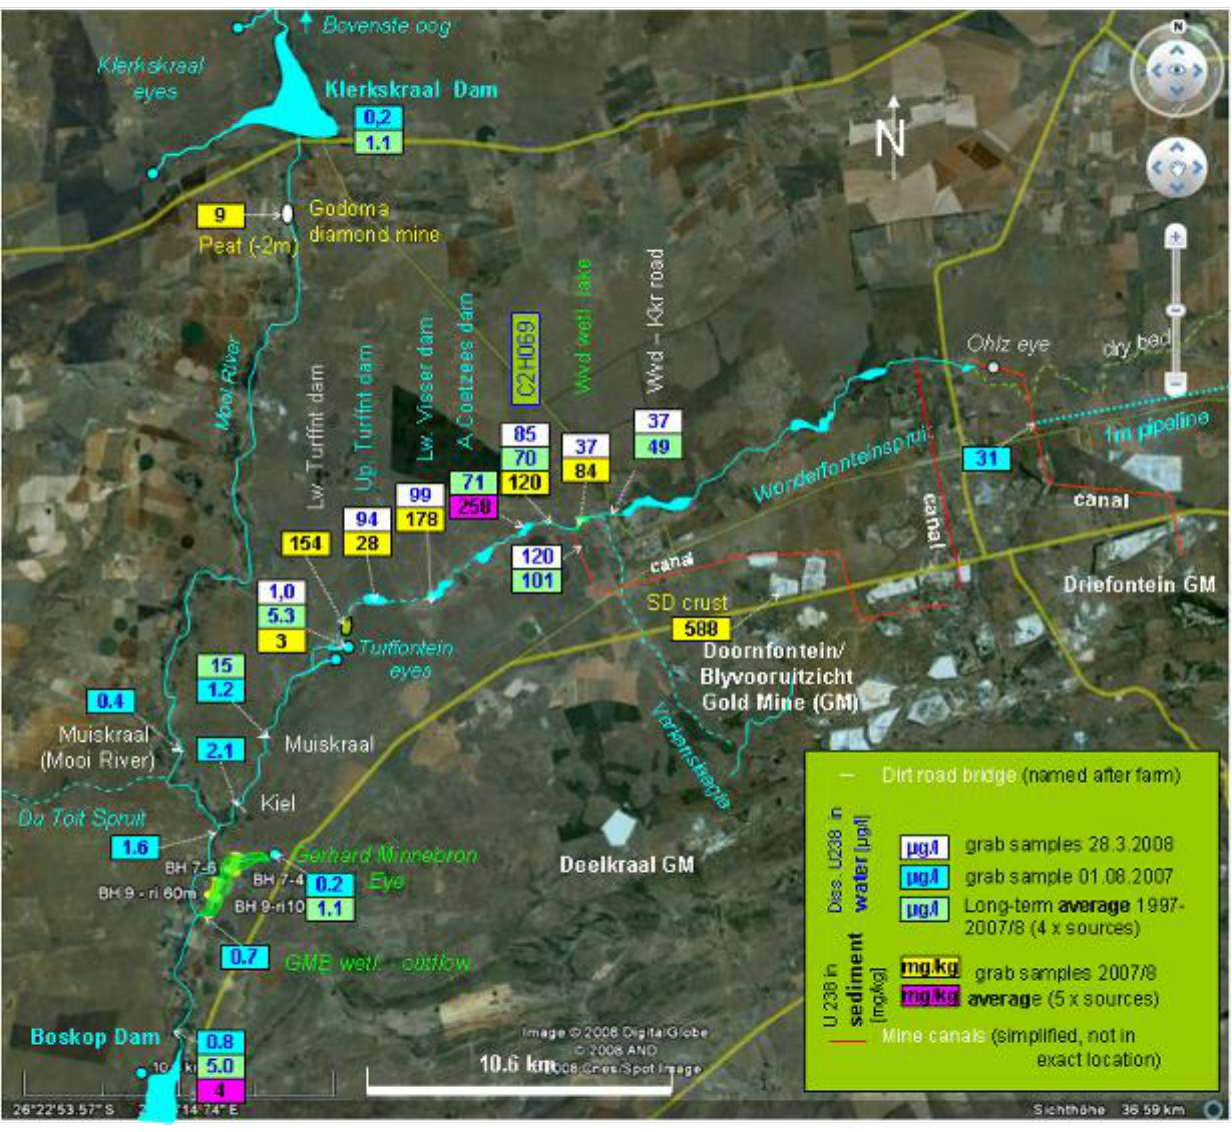
Figure 1. Uranium (U) concentration in water and sediments in and around the Gerhard Minnebron wetland as found in different studies (map based on satellite image of the study area as retrieved from Google